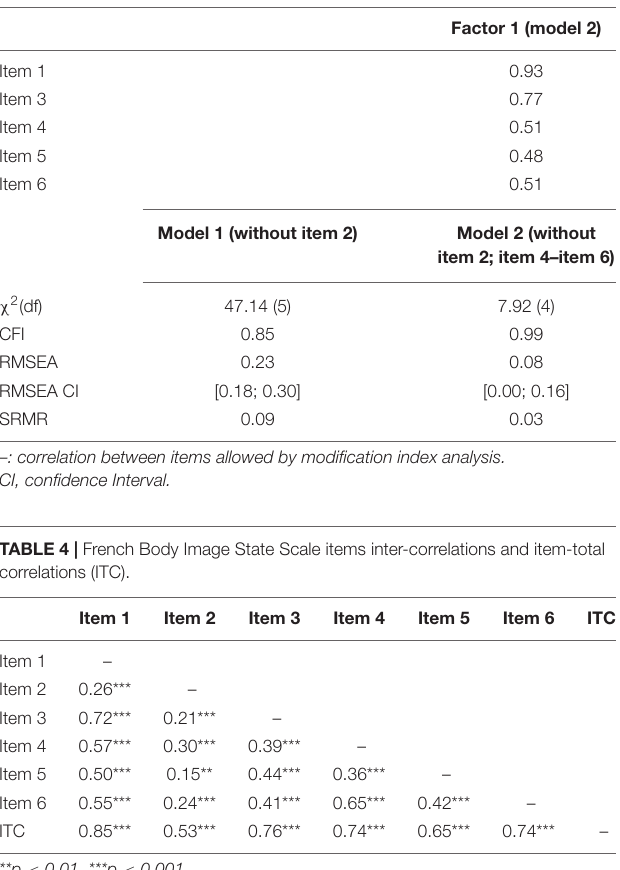
TABLE 3 | Confirmatory factorial analysis, and goodness-of-fit indices of the F-BISS.